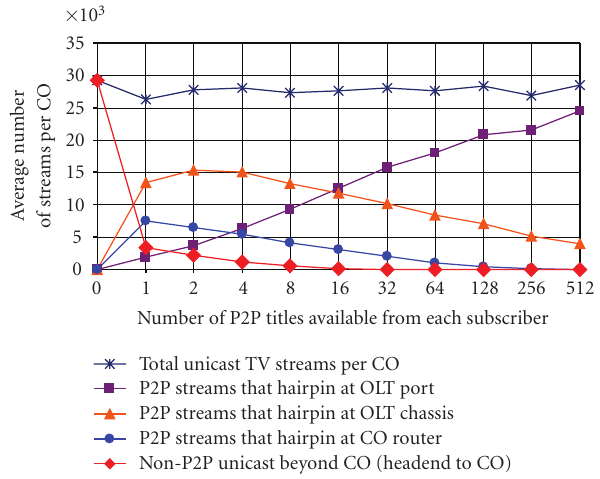
Figure 5: Detailed results: average numbers of streams. NG-PON.